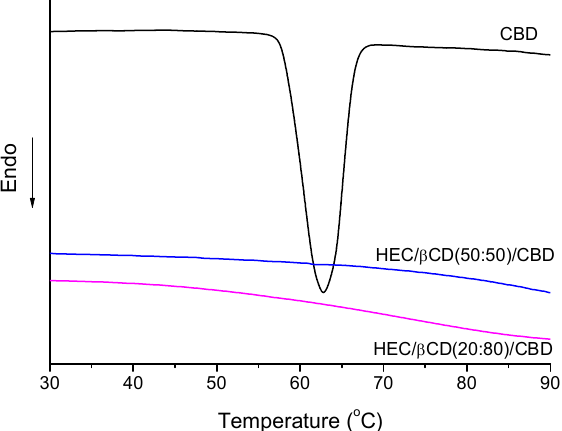
Figure 6. DSC thermograms of CBD-loaded HEC/ β -CD cryogels and pure CBD.